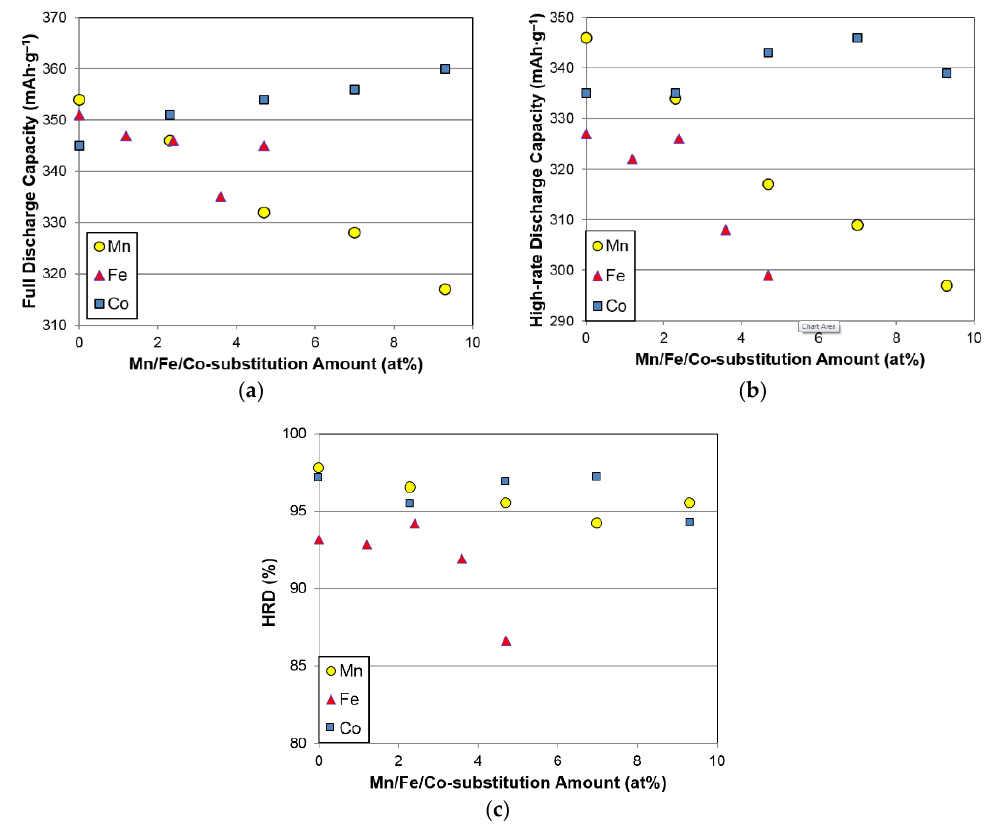
Figure 9. Changes in ( a ) full and ( b ) high-rate (100 mA ∙ g ‒ 1 ) capacities; and ( c ) their ratios (HRD) with increasing substitution amounts.